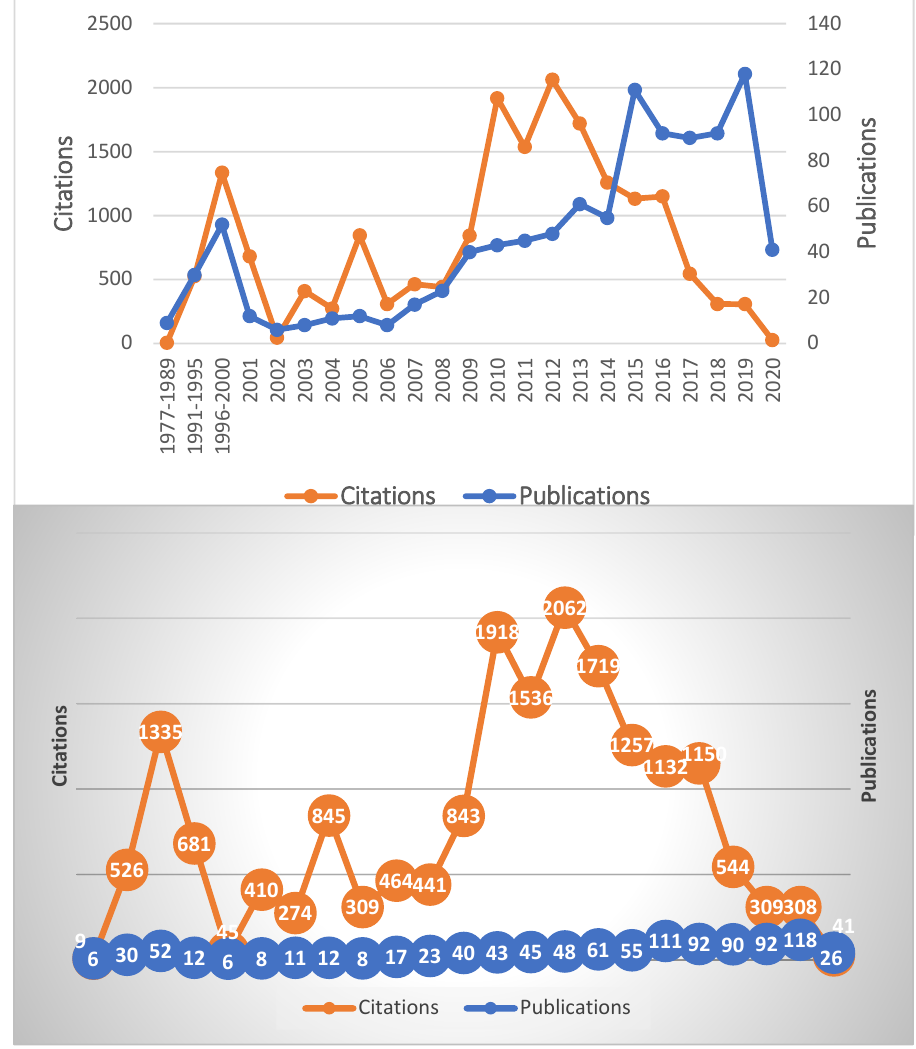
Figure 2. Publication and citations trend on green marketing research (1977–2020).